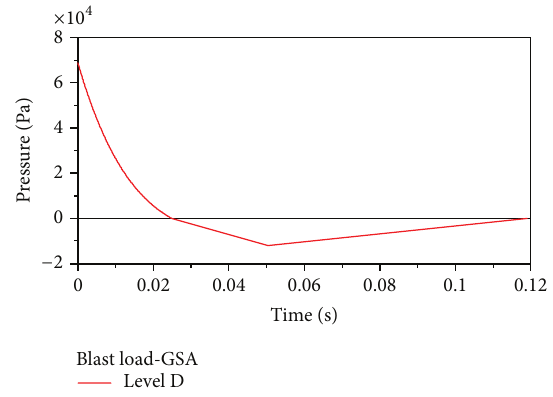
Figure 5: Blast loading time-varying pressure functions (Level D- GSA